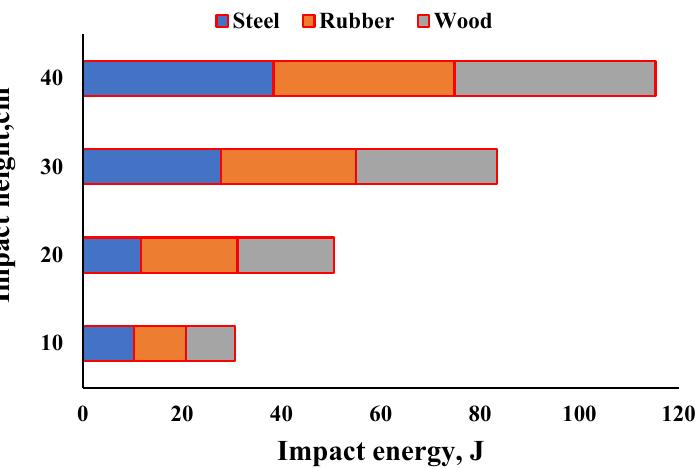
Figure 9. Impact energy of fruit due to different impact height at different impacted surfaces.